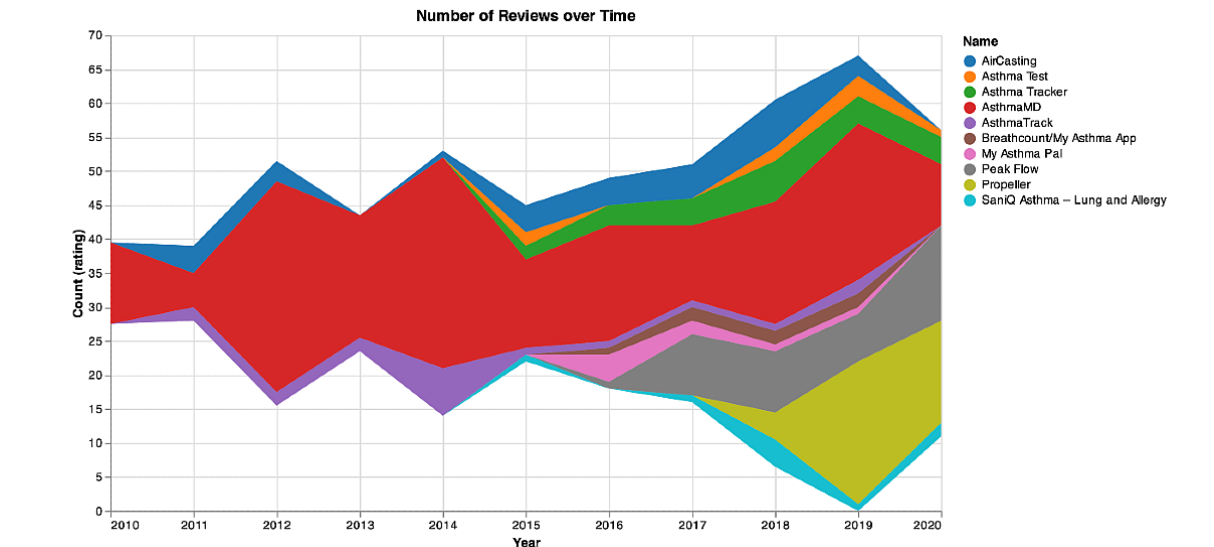
Figure 1. Stream graph of the review counts for asthma apps from 2010 to 2020.